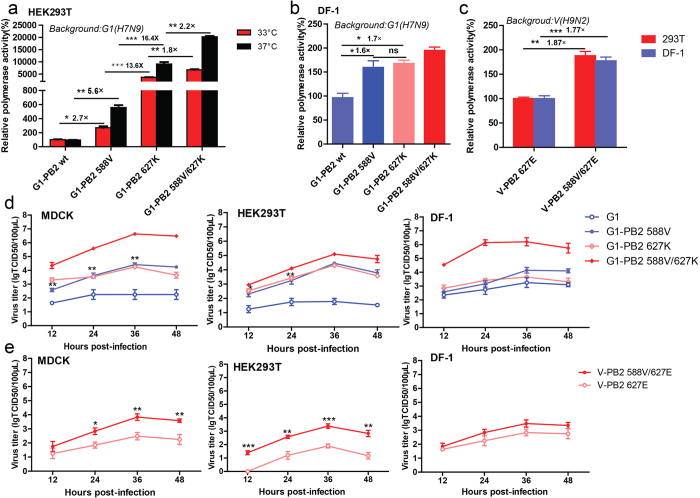
Polymerase activity and growth kinetics of avian-origin H7N9 (or H9N2) viruses possessing different PB2 genotypes.(a–c) Polymerase activity. HEK293T and DF1 cells were co-transfected with the RNP complex of the H7N9 virus (a,b) or H9N2 virus (c) with different PB2 genotypes. The data are the mean of three independent experiments ± SD. (d,e) Growth kinetics of the avian-origin H7N9 G1 virus or H9N2 virus and their variants possessing PB2 588V, 627K, or 588V/627K were compared in MDCK, HEK293T and avian DF-1 cells. Means of triplicate experiments are shown, with error bars representing the standard deviation. Statistical difference between the single PB2 588 mutant viruses compared with their respective parent viruses were labeled (*P < 0.05, **P < 0.01, ***P < 0.001).